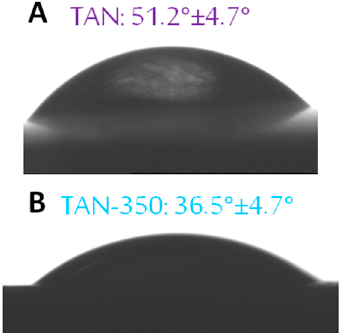
Figure 6. Contact angles of ( A ): TAN ( B ): TAN-350 samples